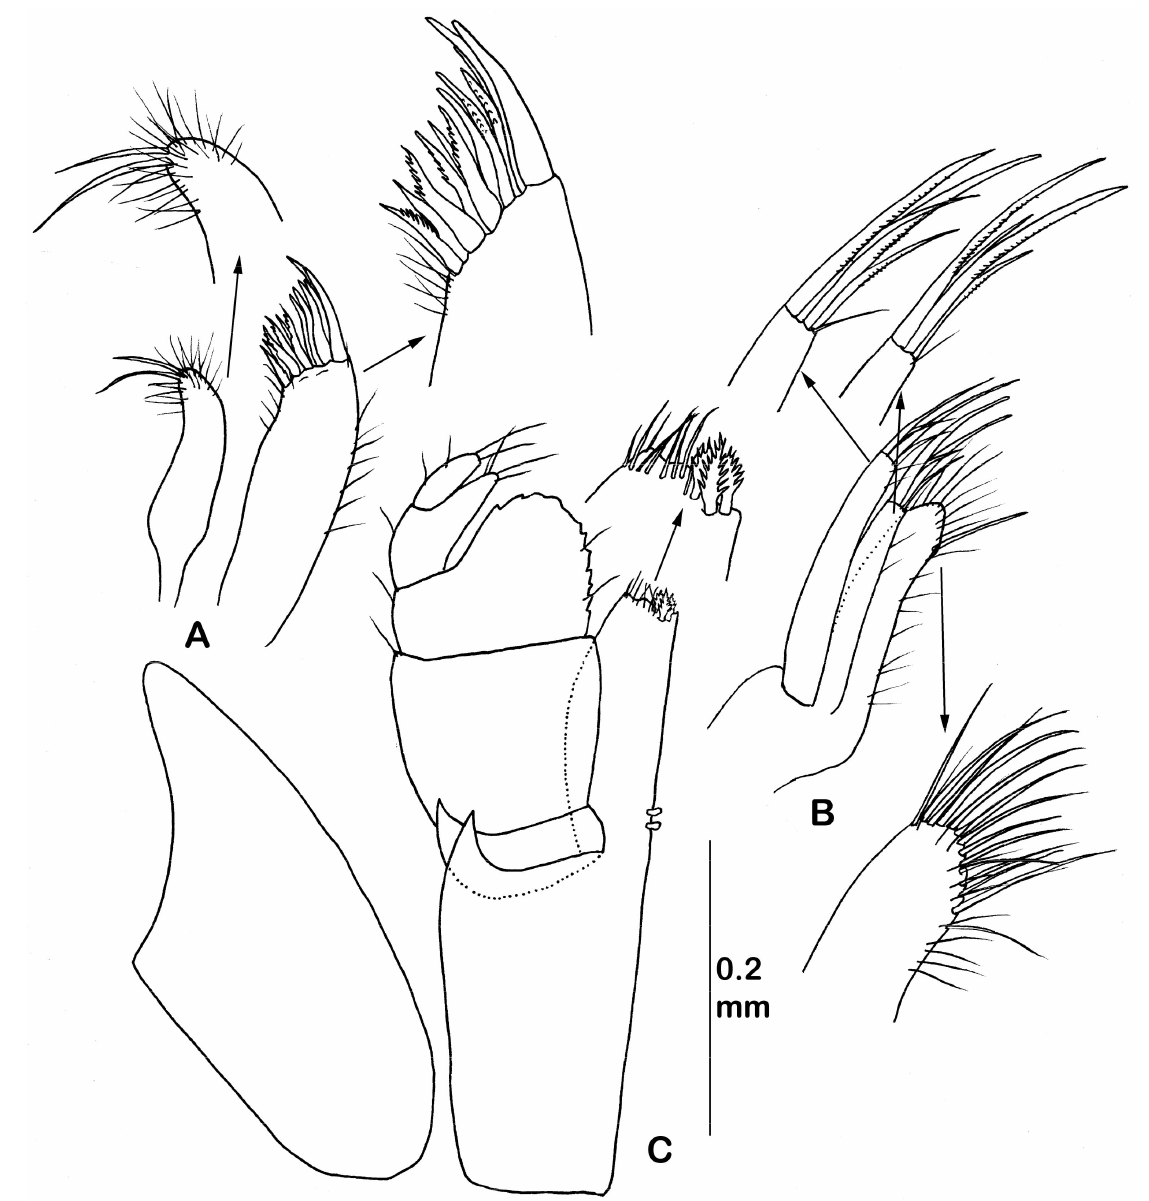
Figure 28. Eurycope emmae sp. nov. Male paratype (ZMH K-45654): ( A ) maxilla I; ( B ) maxilla II; ( C ) maxilliped (all mouth parts with enlarged distal